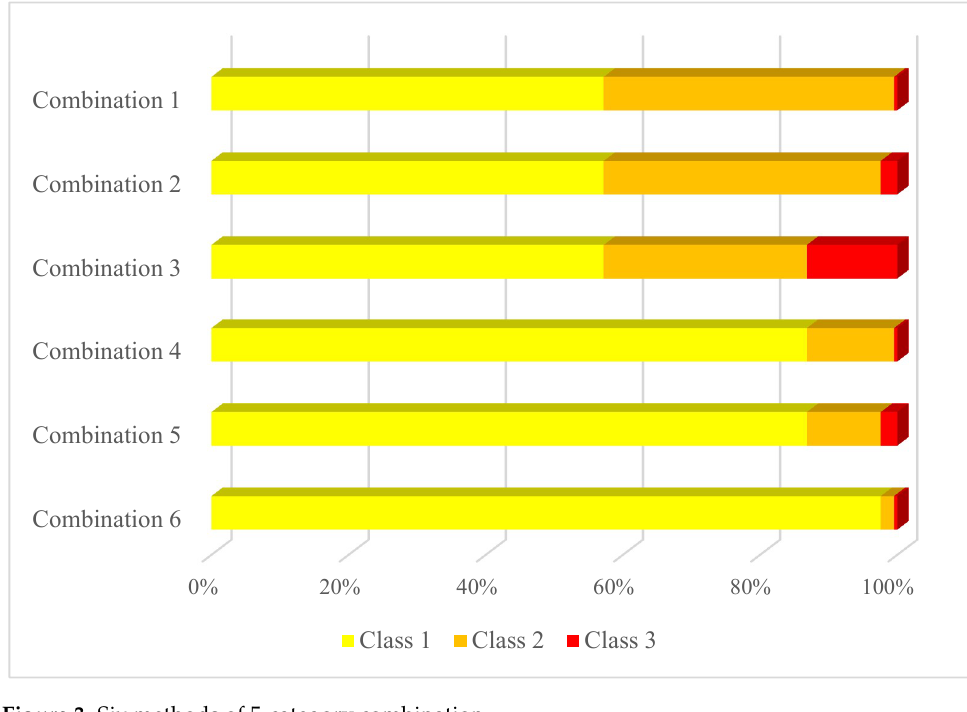
Figure 3. Six methods of 5-category combination.